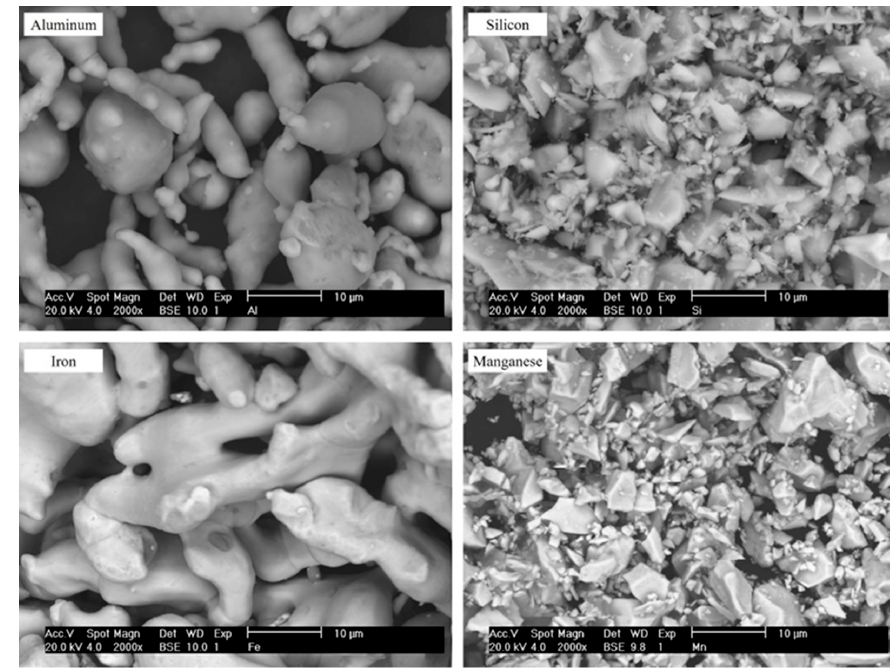
Figure 1. Scanning electron microscopy (SEM) images of Al, Si, Fe, and Mn powders.